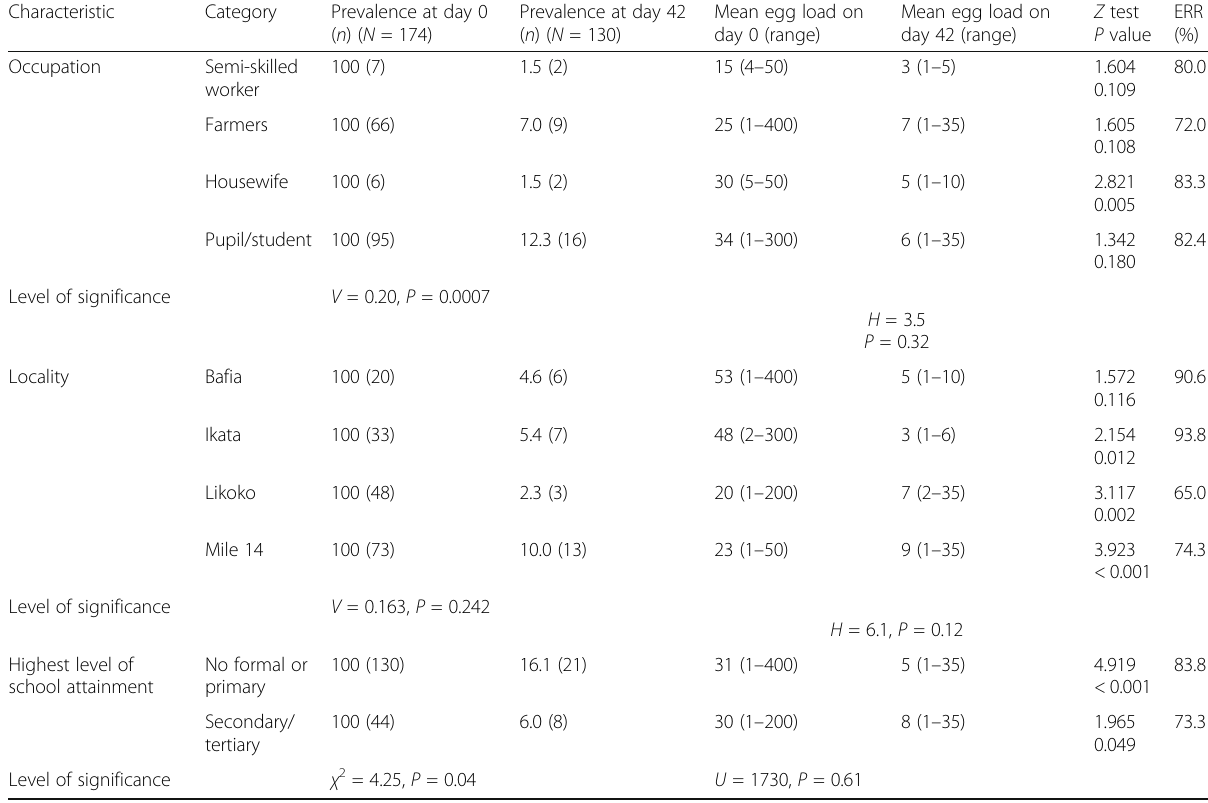
Table 3 Efficacy of praziquantel against S. haematobium with respect to socio-demographic factors and locality